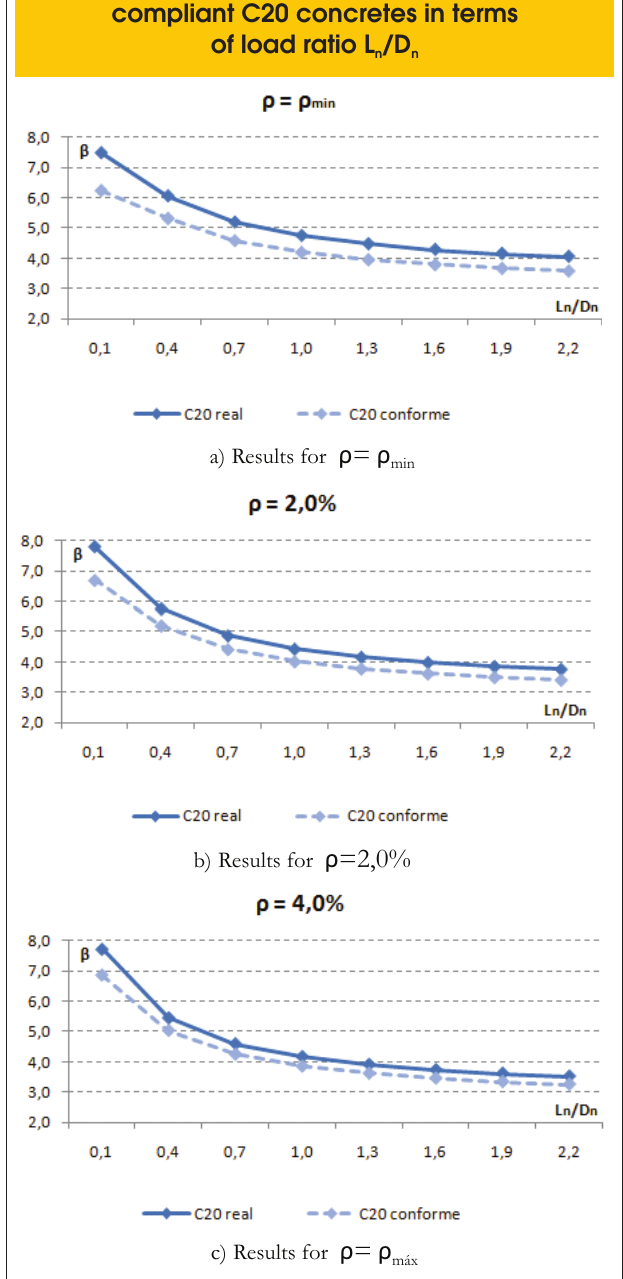
Figure 5 – Reliability index results for real